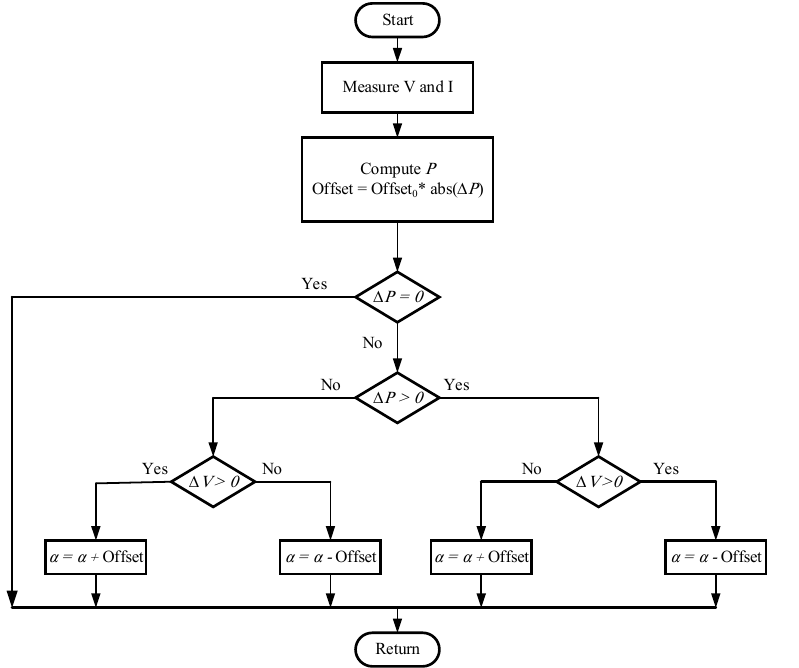
Figure 3. Flowchart of modified P&O algorithm.